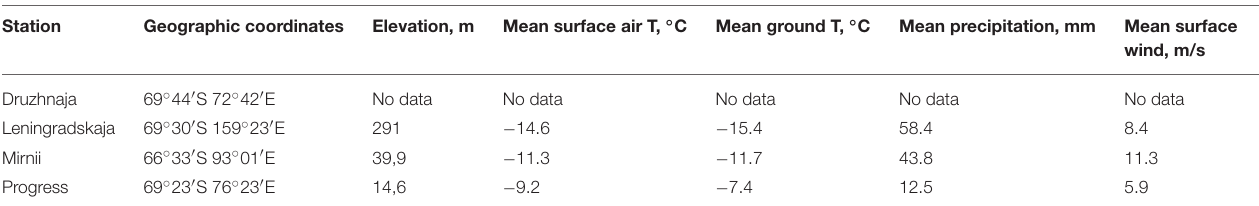
TABLE 1 | Geographical and climatic data for the four sampling